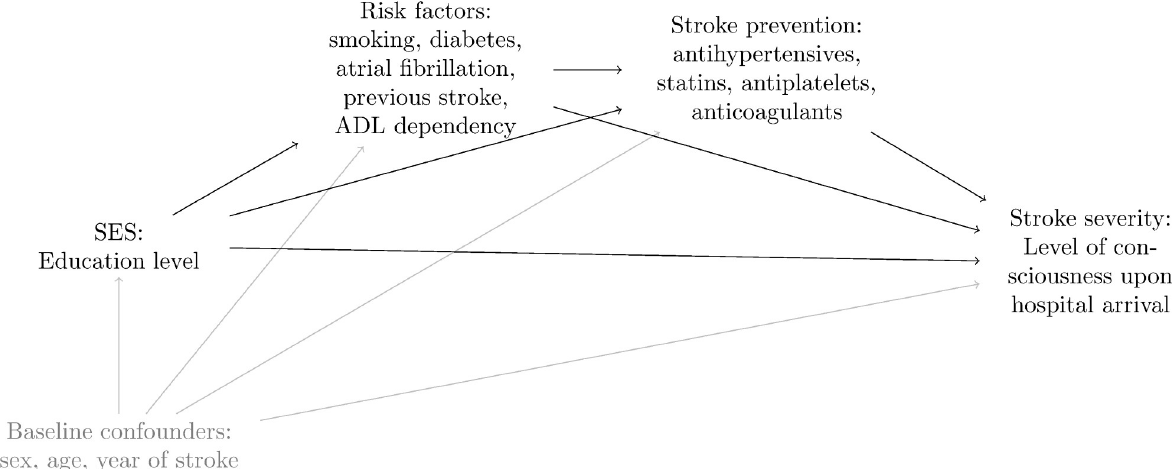
Fig 1. DAG illustrating the hypothesized relationships between the variables in the study.